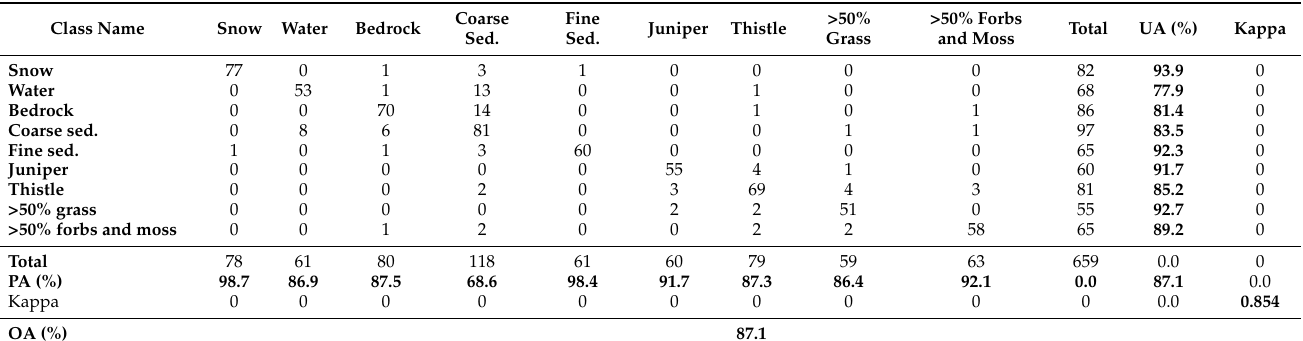
Table 4. Accuracy assessment. Confusion matrix displaying the accuracy values of the validation samples for each target class + overall accuracy, producer’s accuracy, user’s accuracy and Kappa Coefficient for the final